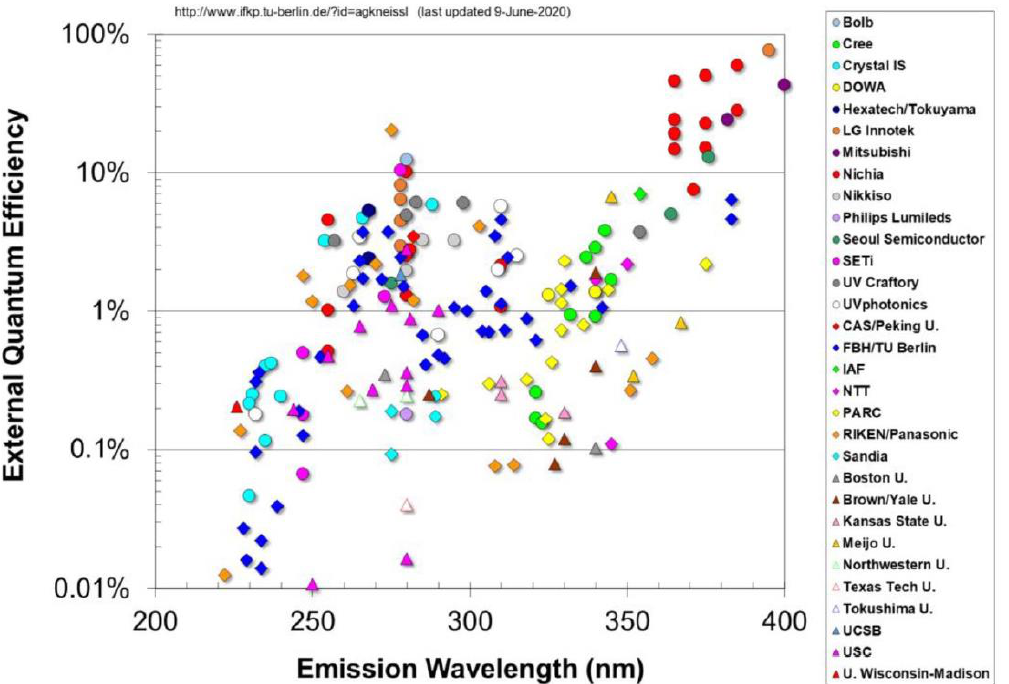
Figure 2. EQEs of UV LEDs in spectral range between 200 and 400 nm [7].